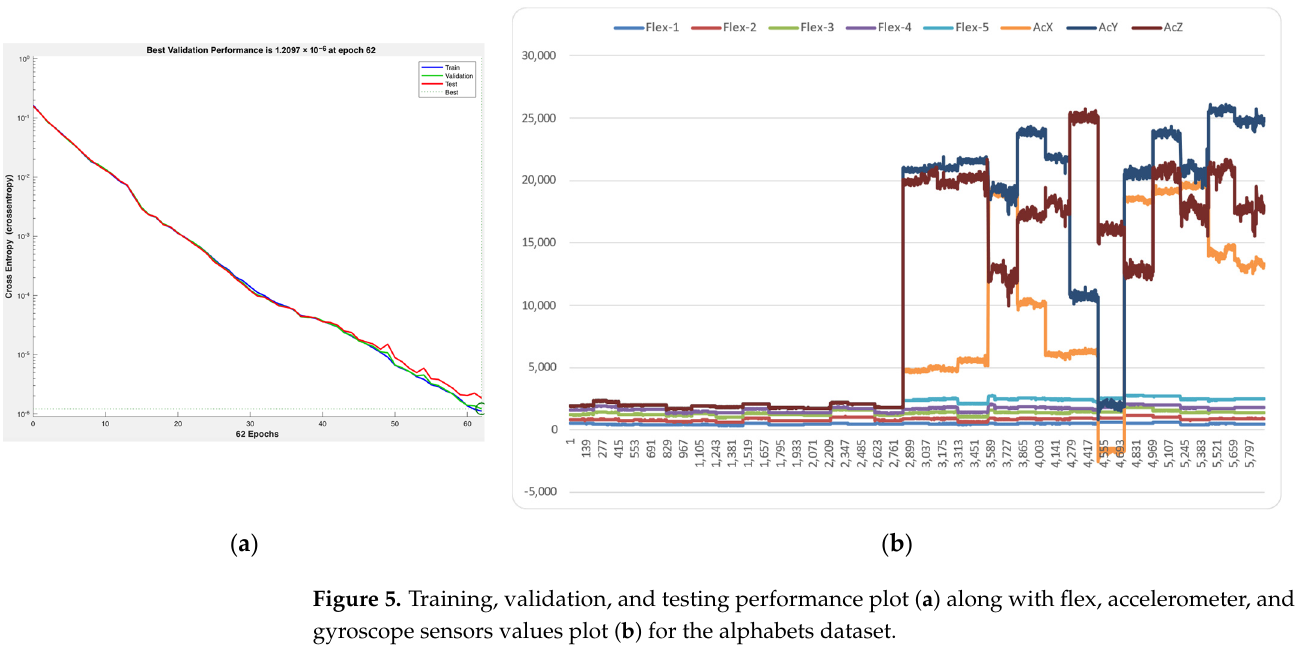
Figure 5. Training, validation, and testing performance plot (on left) along with flex, accelerometer, and gyroscope sensors values plot (on right) for the alphabets dataset.